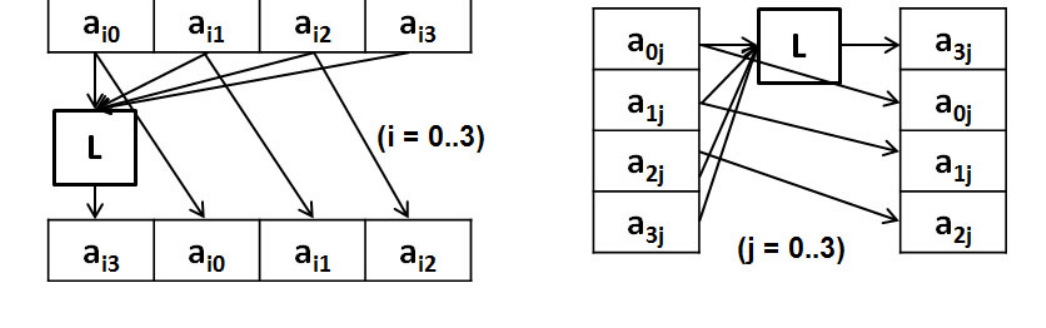
Figure 4: The scheme of conversion LT